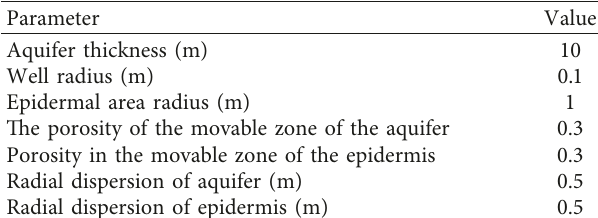
Table 4: Parameter values in the